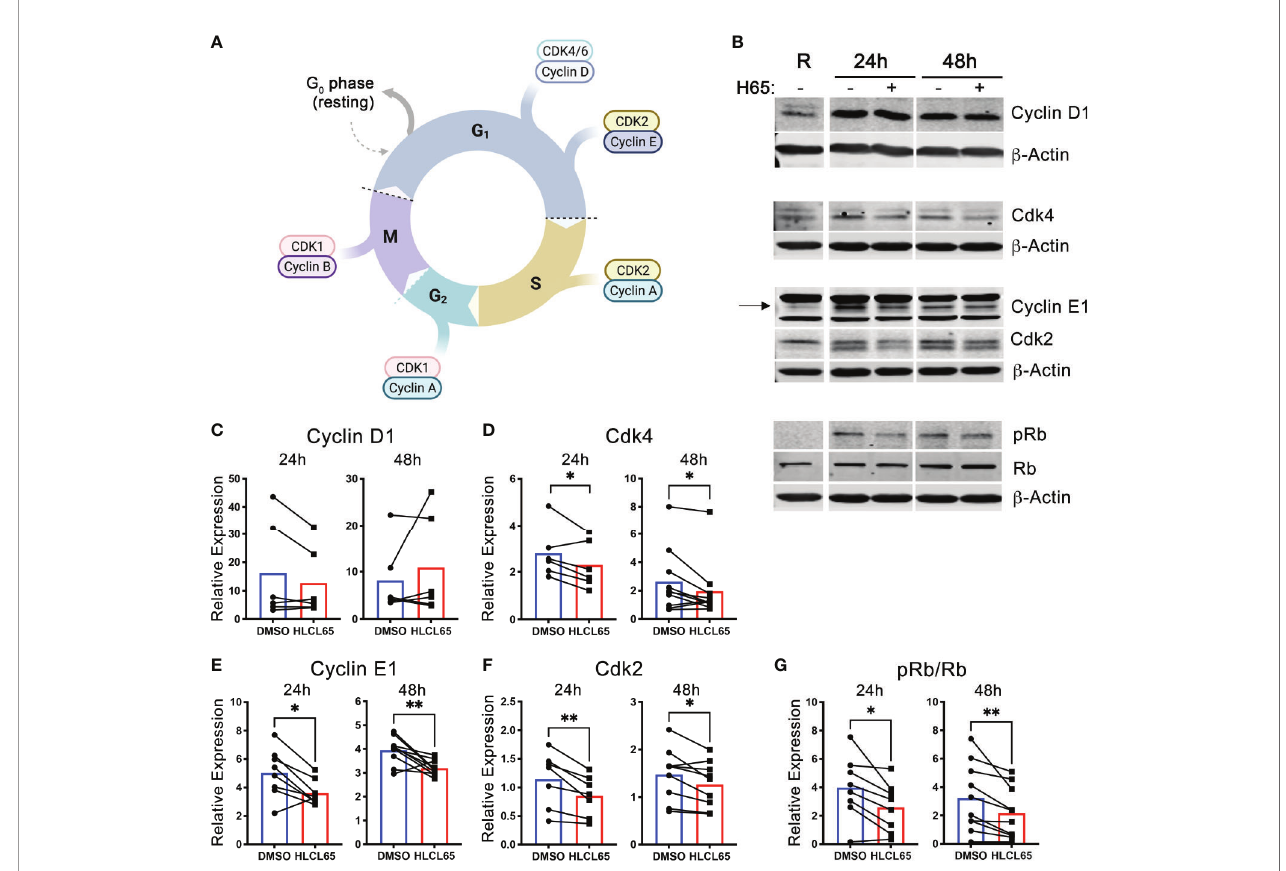
FIGURE 2 | PRMT5 inhibition suppresses Cyclin E1/CDK2 expression and Rb hyperphosphorylation in in fl ammatory T cells. (A) Diagram of the expression of cyclins and CDKs at the different cell cycle stages. Created with BioRender.com, modi fi ed from a template. (B – G) mTh1 cells were activated on anti-CD3/CD28 coated plates, treated with 5 µM HLCL65 or vehicle control (DMSO) and harvested at various timepoints for protein analyses. (B) Immunoblots of mTh1 cells probed with cell cycle proteins at resting, 24h and 48h post-plating. (C – G) Protein quanti fi cation of (C) Cyclin D1, (D) Cdk4, (E) Cyclin E1, (F) Cdk2, (G) ratio of phosphorylated Rb at S608 to total Rb. DMSO values are relative to resting. Data pooled from 4-6 independent experiments, n=6-10, student ’ s paired t-test. *p < 0.05, **p <